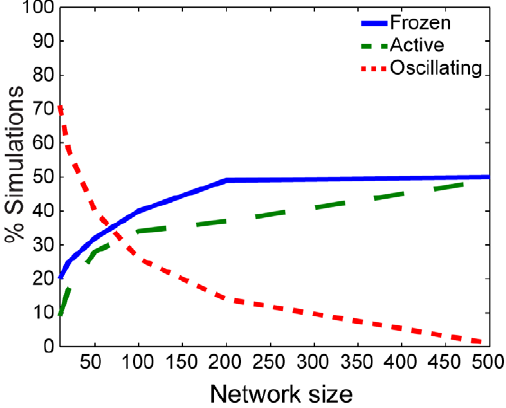
Figure 3. Dependence on network size for qualitative states for k h , x ~ 0 : 01 and s v ~ 1 . Percentage of simulations in which the qualitative dynamics have switches off and oscillators frozen (blue, solid), switches on and oscillators synchronized (green, dashed), and oscillatory switches and synchronized oscillators (red, dotted).